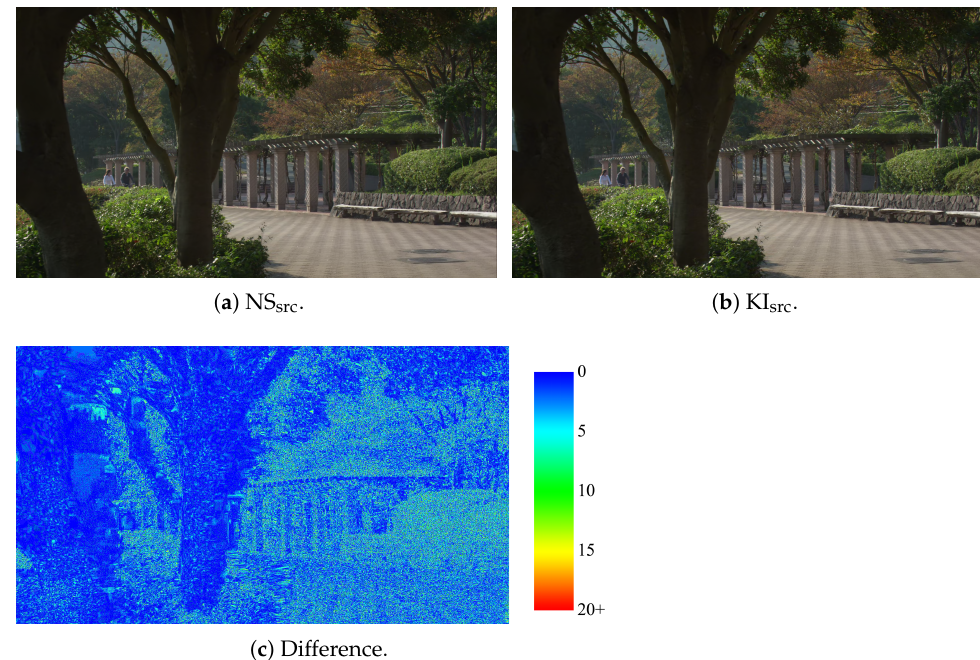
Figure 7. Frames of the ParkScene -sequence with QP NS = QP CS = 27. ( a ) The frame of NS src without drift-error artifacts. ( b ) The frame of KI src with drift-error artifacts. ( c ) The differences between subfigures ( a , b ). It is recommended to view these images in color,